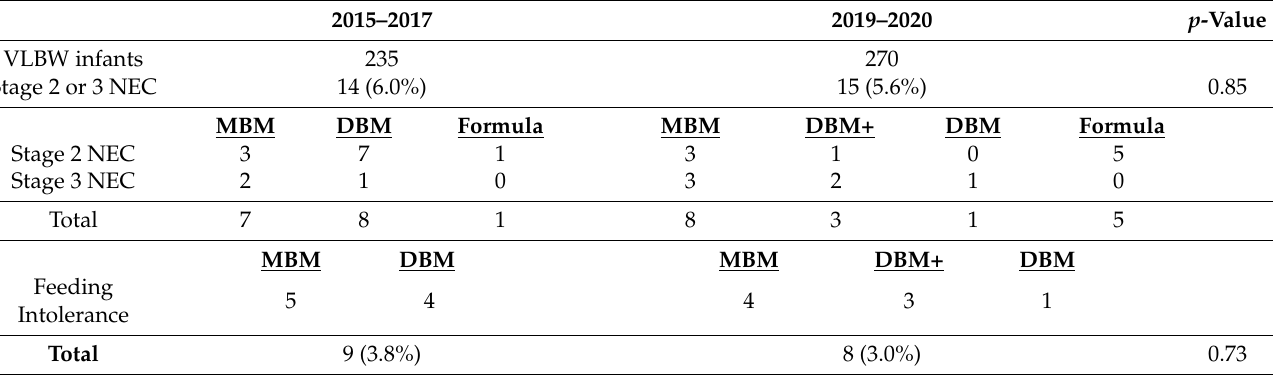
Table 3. Incidence of NEC and feeding intolerance between cohort eras.